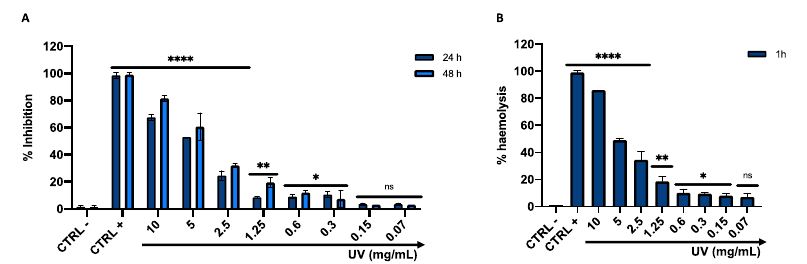
Figure 7. ( A ) HaCaT cytotoxicity after 24 and 48 h of treatment with Arctostaphylos uva-ursi leaf extract. ( B ) In vitro hemolysis assay after erythrocyte exposure to Arctostaphylos uva-ursi leaf extract.